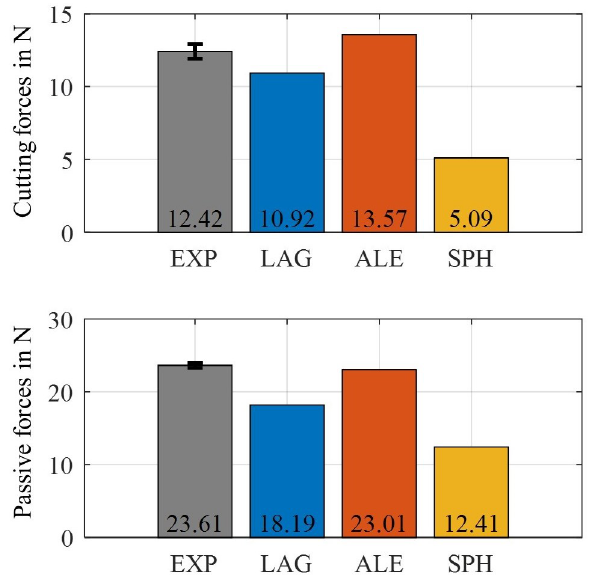
Figure 13. Process forces of measurement and discretization approaches for a 3D single grit scratch (cutting speed v c = 200 mm/s, depth of cut a p = 50 µm that corresponds to a p ,sim = 30 µm, cone angle of 105 ◦